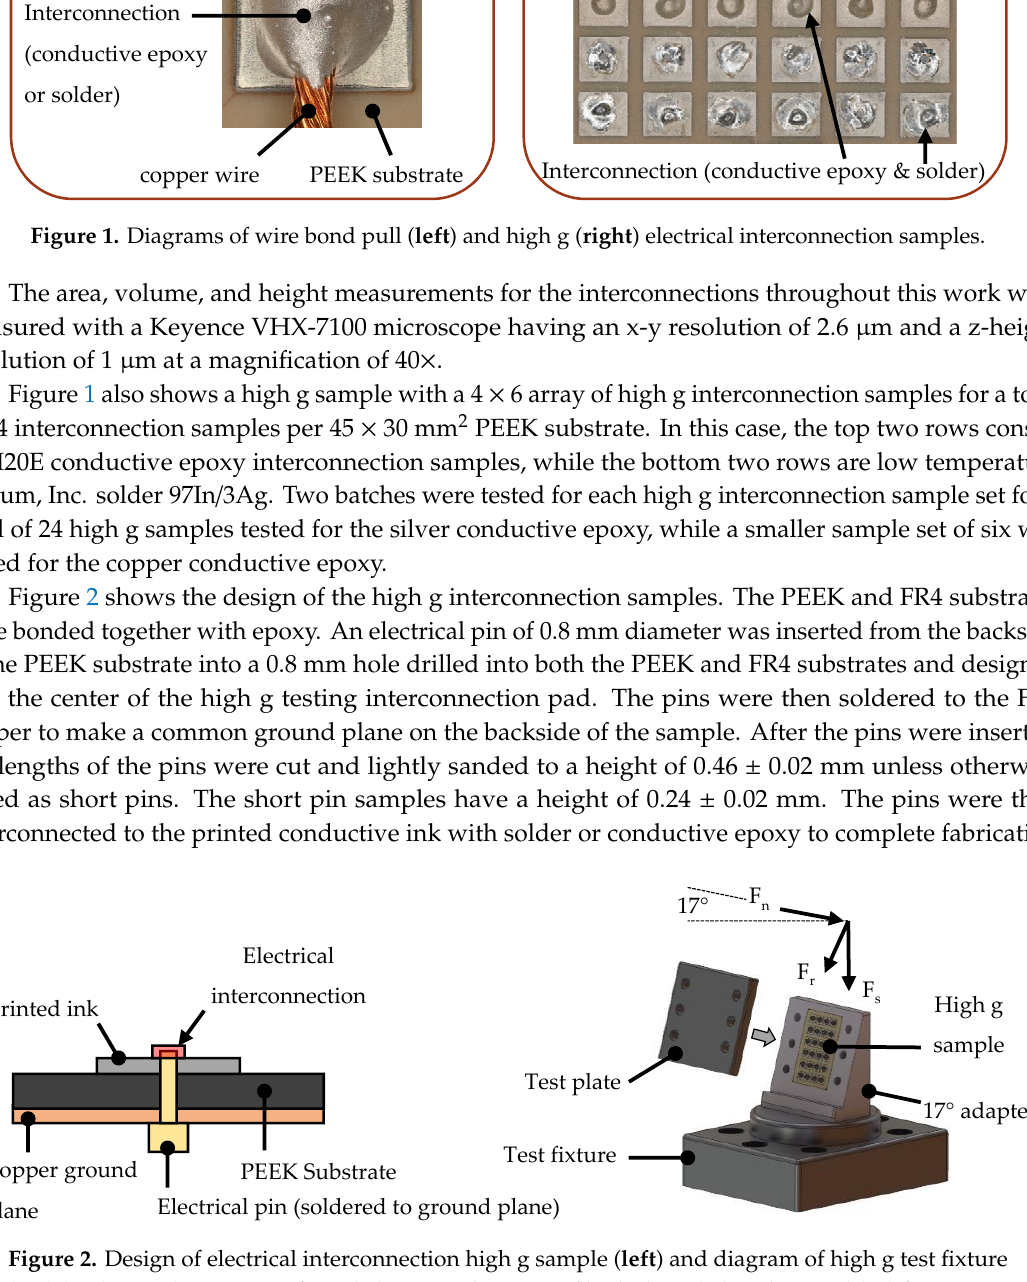
a pulse width of 0.1 ms, which fits the profile of MIL STD 883F Method 2002.4 Mechanical